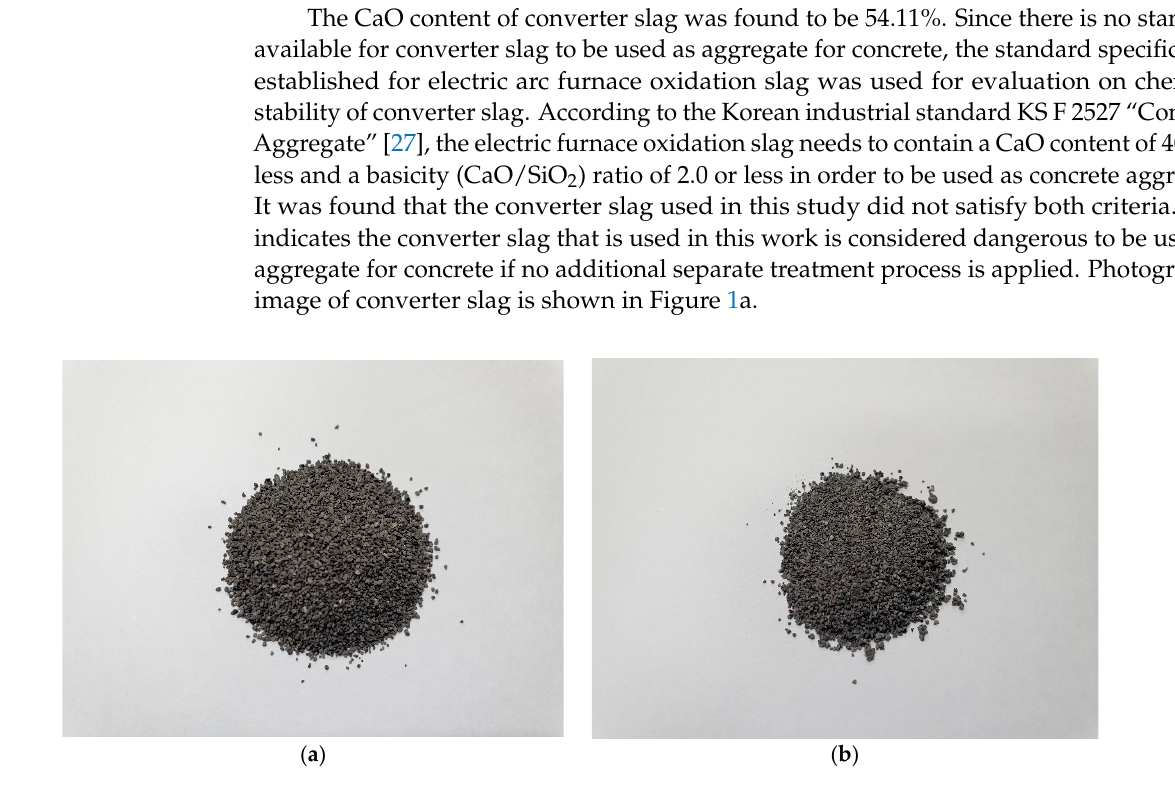
Figure 1. Photographic images of converter slag ( a ) before and ( b ) after reaction with supercritical carbon dioxide (SCD).